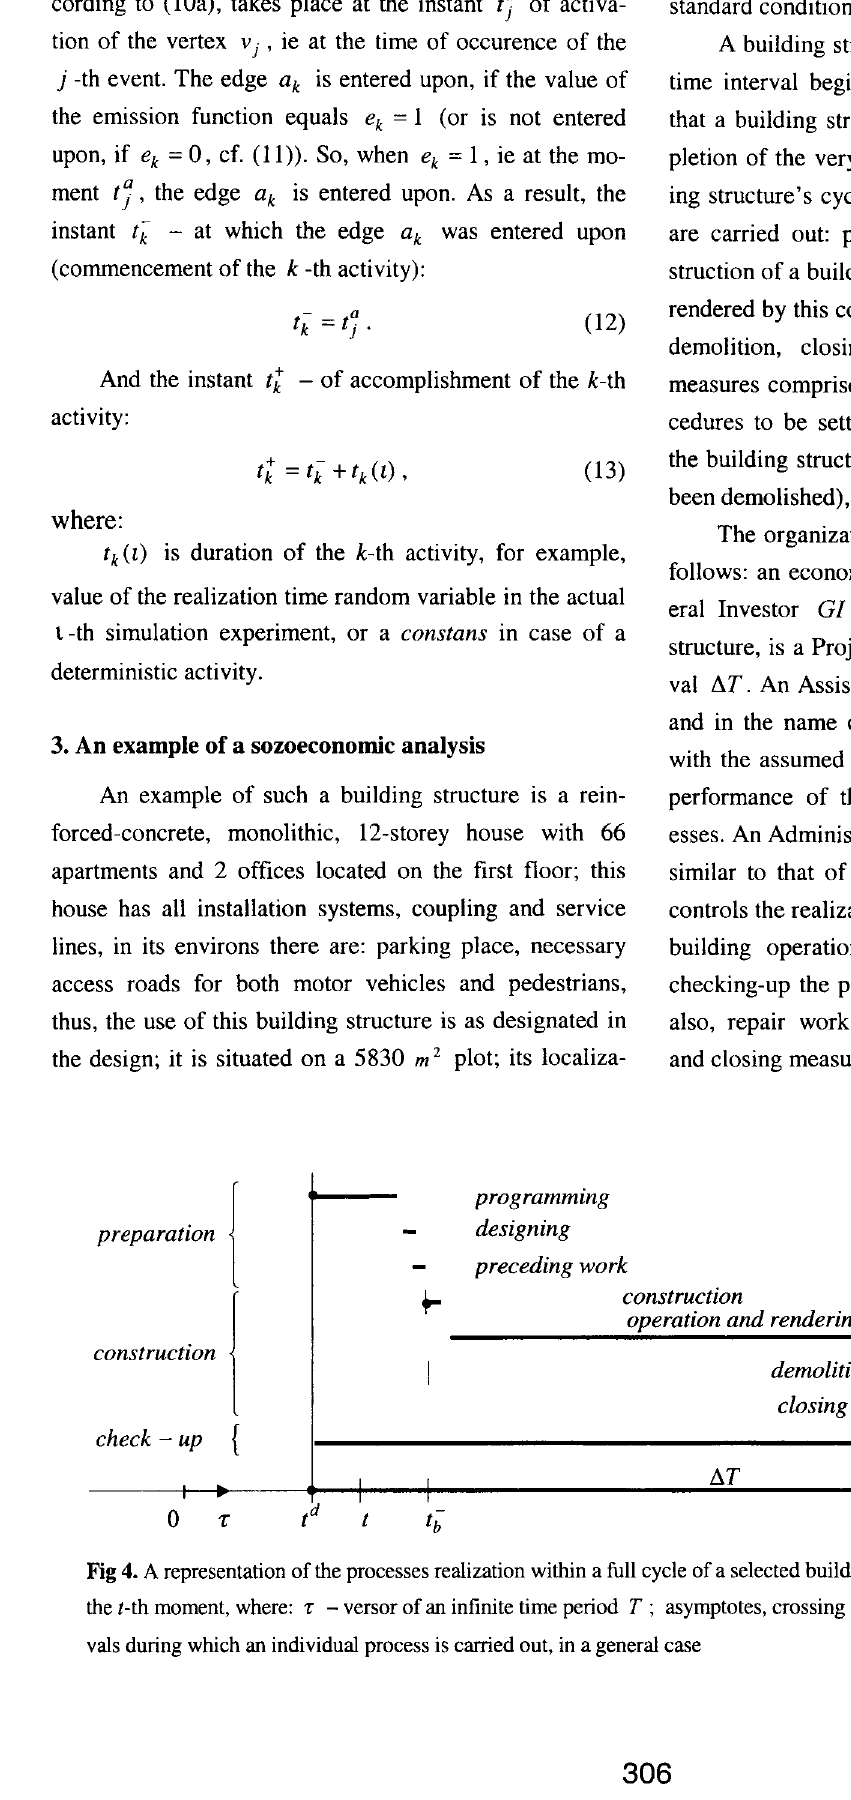
Fig 4. A representation of the processes realization within a full cycle of a selected building structure during a time interval ~T . in the t-th moment, where: -r - versor of an infinite time period T ; asymptotes, crossing the points t d , t;; , t vals during which an individual process is carried out, in a general